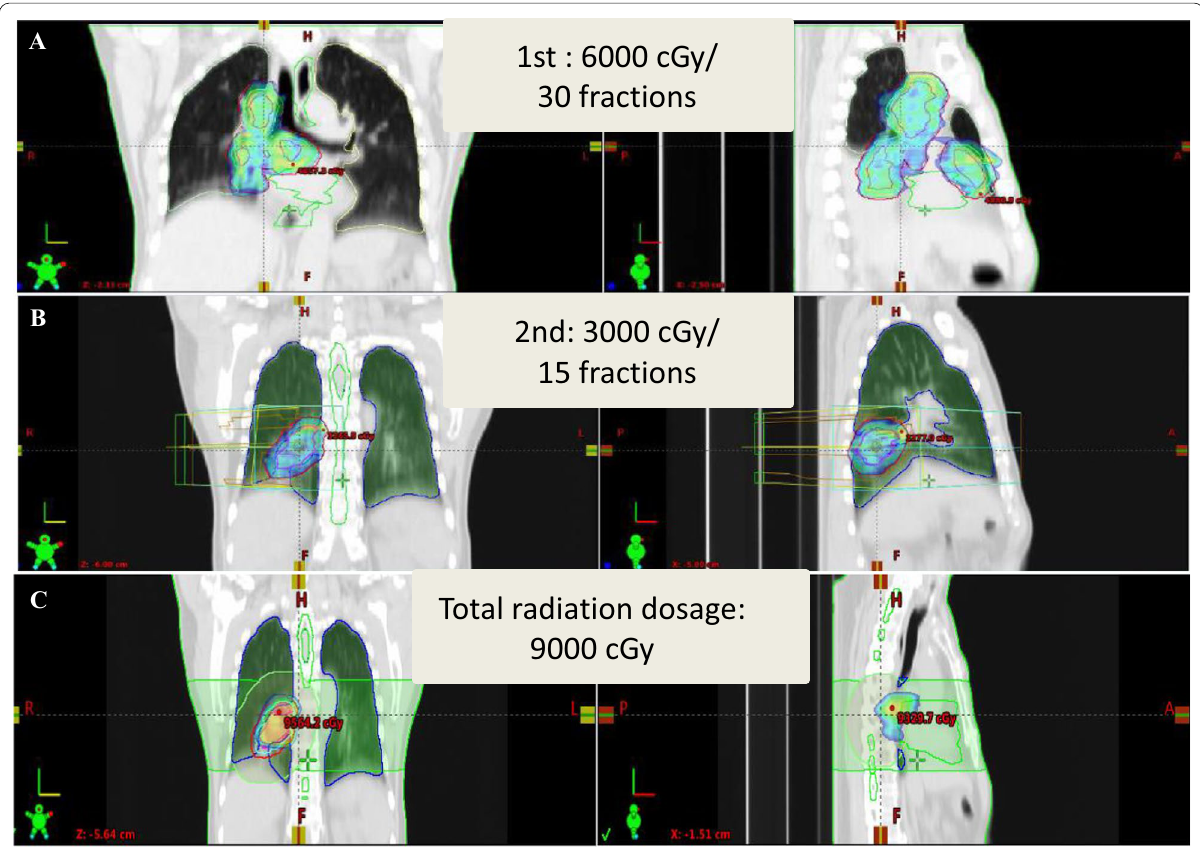
Fig. 3 Definitive radiotherapy with radical intent was delivered. a The 1st R/T: 6000 cGy/ 30 fractions for gross tumor volume (GTV) onto the primary tumor over the RLL grossly mediastinal LAPs; b the 2nd R/T: 3000 cGy/ 15 fractions for gross tumor volume onto RLL lung tumor; c total + radiation dosage: 9000